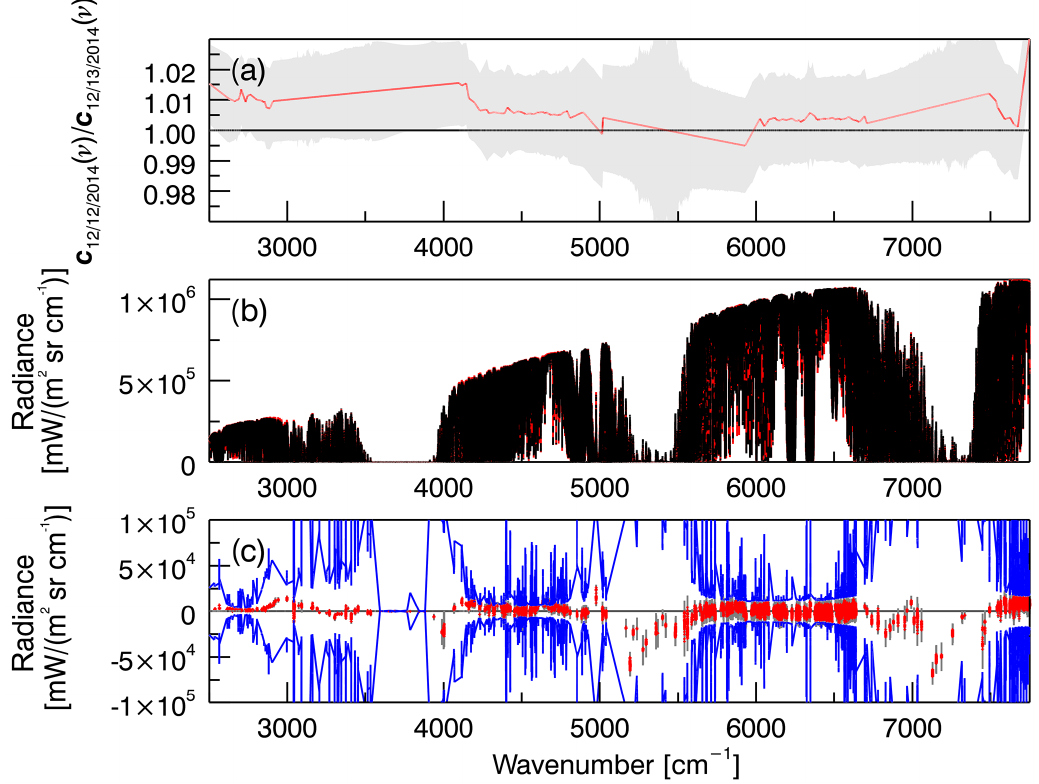
Figure 7. Examination of calibration results. (a) Ratio of the combined calibration curves determined from the 12 and 13 December 2013 Langley measurements in combination with the 24 February 2014 blackbody measurements (red line) and 2 σ uncertainty estimate (grey shaded area). (b) Mean measured (black) and synthetic (red) radiance for the validation data set. (c) Mean residual (red dots) and standard deviation of residuals (grey shaded area) for the validation data set outside spectral lines in comparison with the 2 σ residual uncertainty estimate (blue